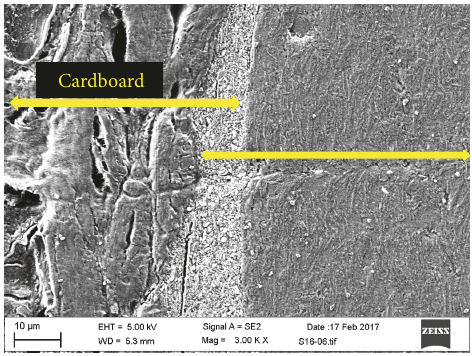
Figure 8: SEM image of a cross-section area of C2, which shows the graphene layer and cardboard